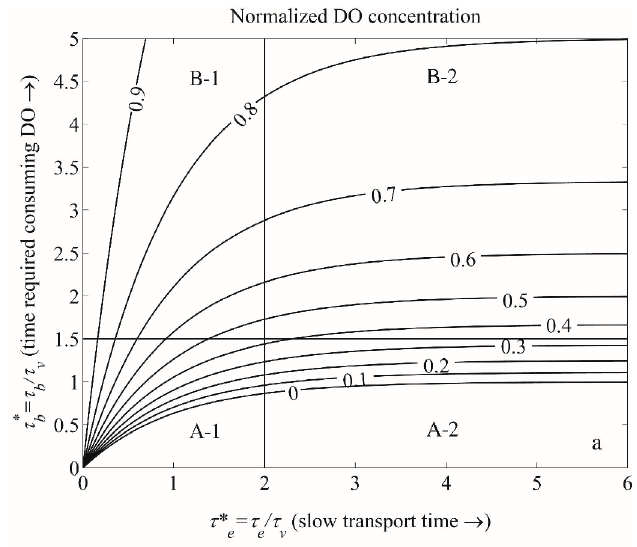
Figure 16. Contours of c : c s (ratio of bottom layer dissolved oxygen concentration (DO) to surface layer DO), as a function of two dimensionless parameters, τ ∗ (the biochemical consumption timescale b normalized by the vertical exchange timescale) and τ ∗ e (the timescale for transport driven by gravitational circulation normalized by the vertical exchange timescale). Based on the simple, timescale-based mathematical model of Shen et al. [21] (Equation (8) herein). Rectangular regions delineate regimes associated with control of DO by particular processes and / or likelihood of hypoxia. (Reuse and minor adaptation from Shen et al. [21], with permission from Wiley. © 2013, by the Association for the Sciences of Limnology and Oceanography, Inc.)